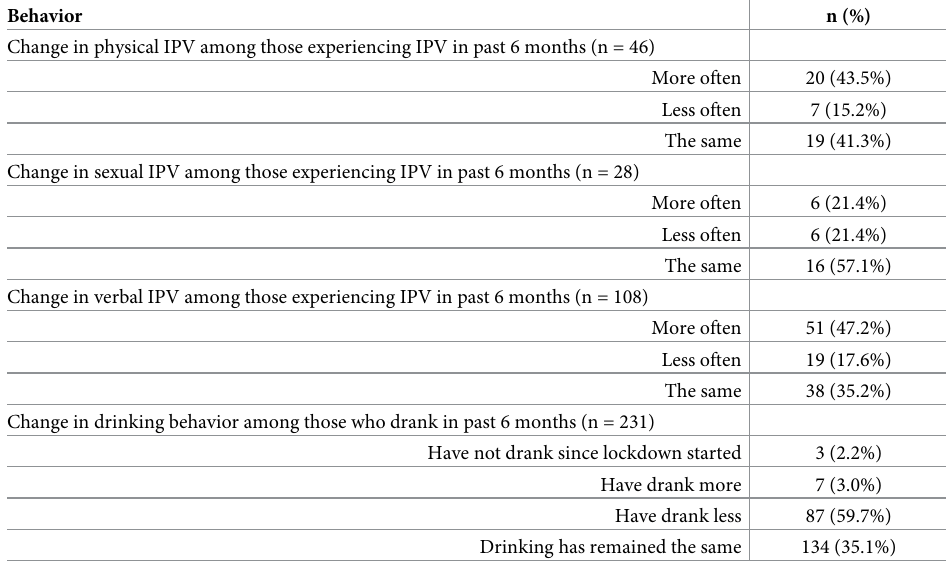
Table 2. Self-reported changes in alcohol use behaviors and frequency of IPV due to the COVID-19 lockdown.